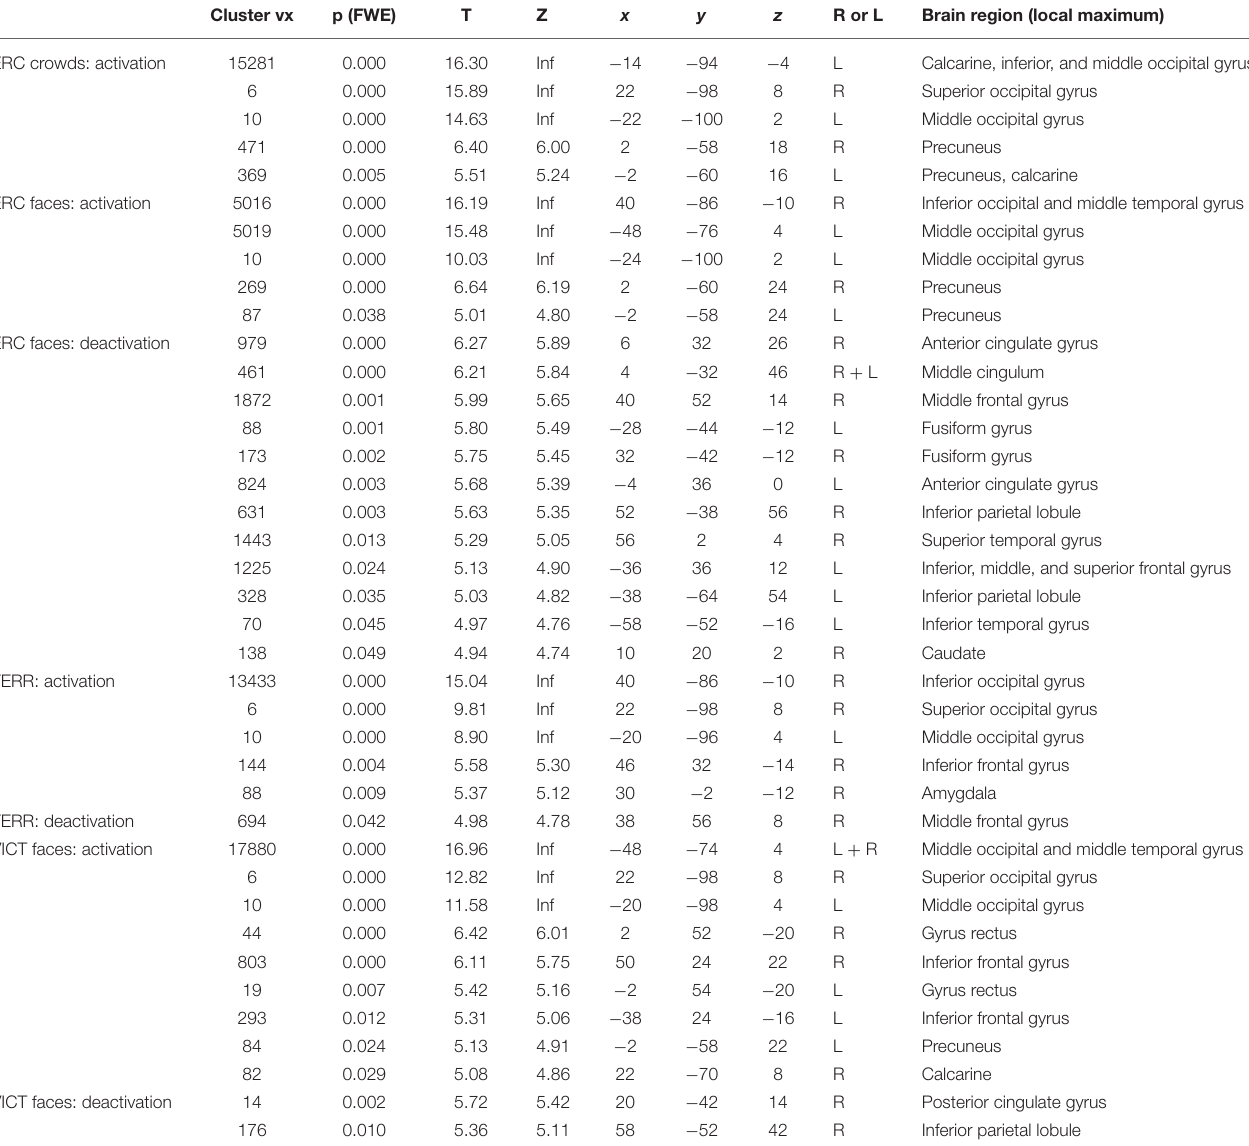
TABLE 2 | The effects of the content of the documentary photographs on brain activity. Cluster